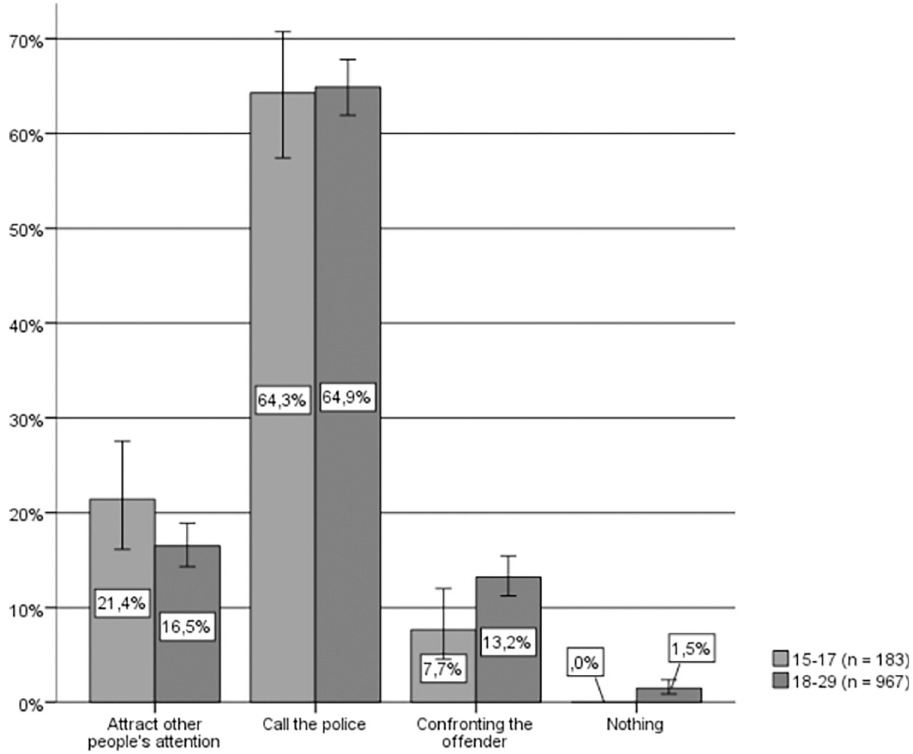
Fig 9. Hypothetical response to IPVAW, young women by age group. Source: Own elaboration based on CIS study 2992 [49], question 14. 95% confidence intervals are provided for each subsample.